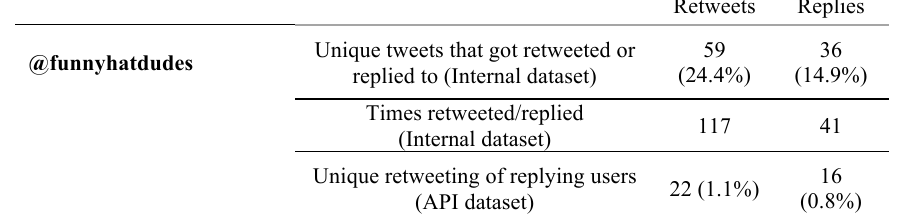
Table 7 . The numbers of unique case account tweets that were retweeted or replied to, the total numbers of retweets and replies and the numbers of unique direct followers, who retweeted or replied to the case account